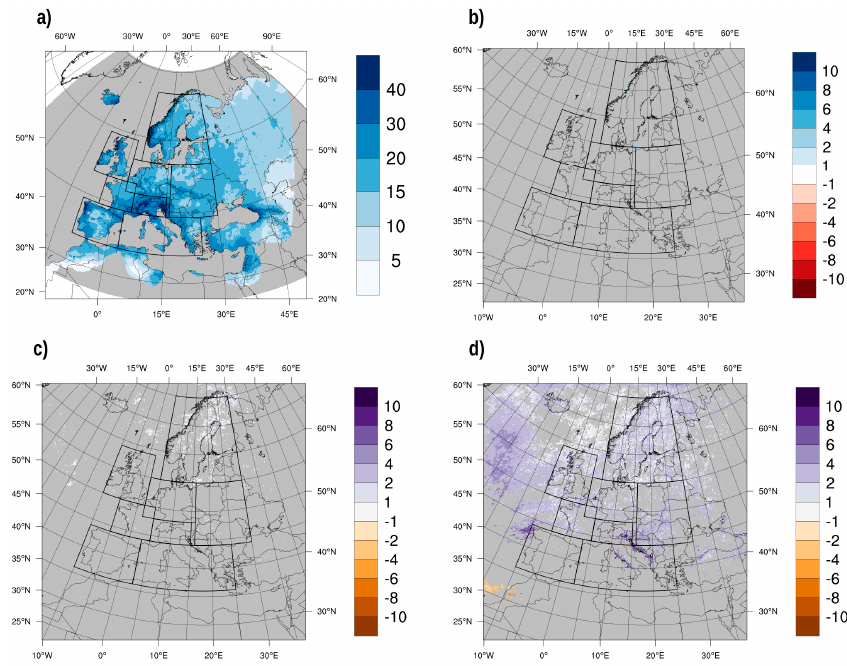
Figure 5. Same as Figure 1, but for the 99th percentile of precipitation in mm/day.